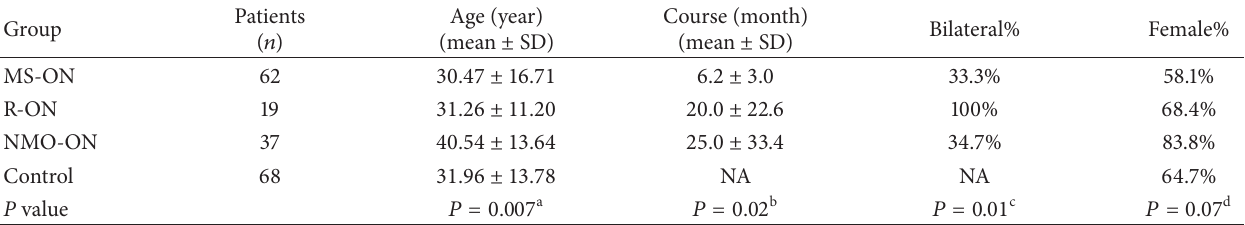
Table 1: Demographics and clinical characteristics for MS-ON, R-ON, and NMO-ON group and control.